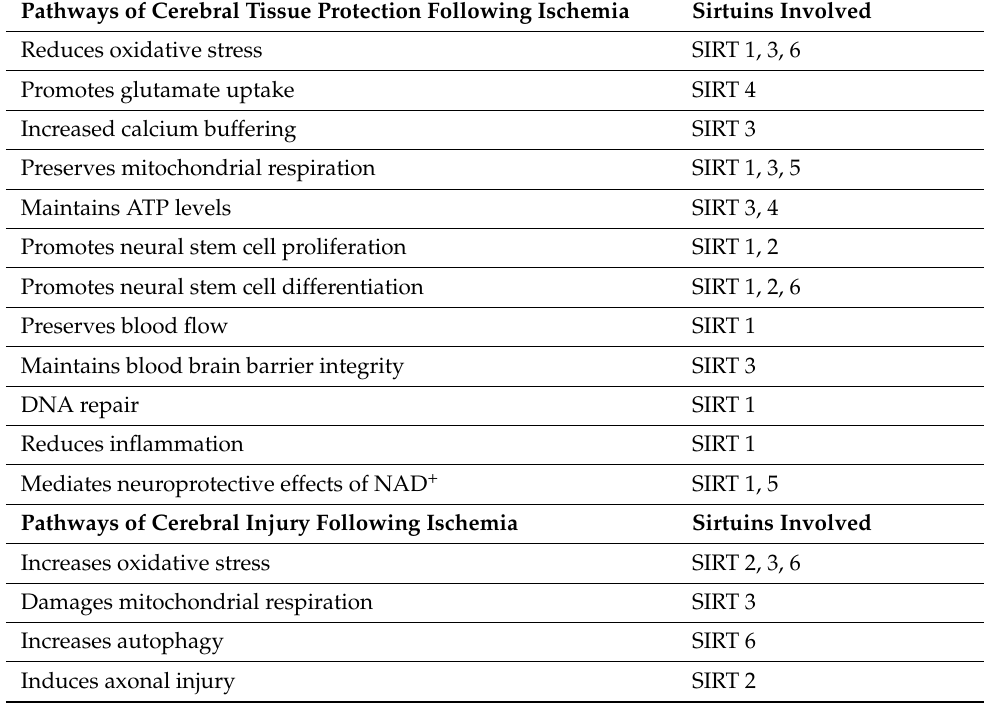
Table 1. Pathways of neuroprotection and neuronal injury mediated by